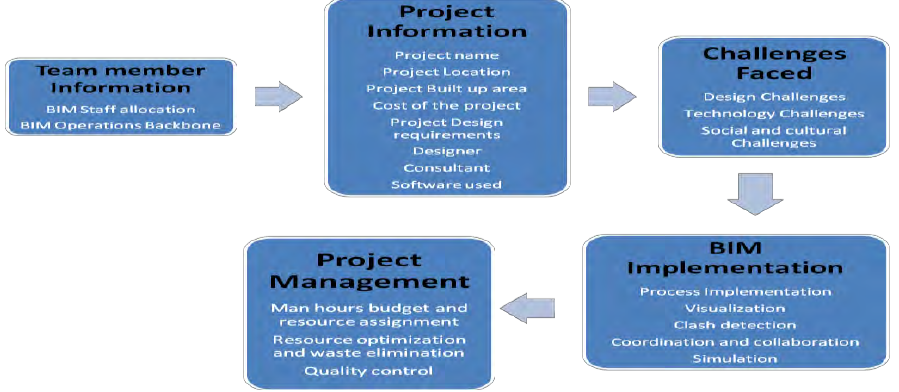
Figure 6. the case study attributes